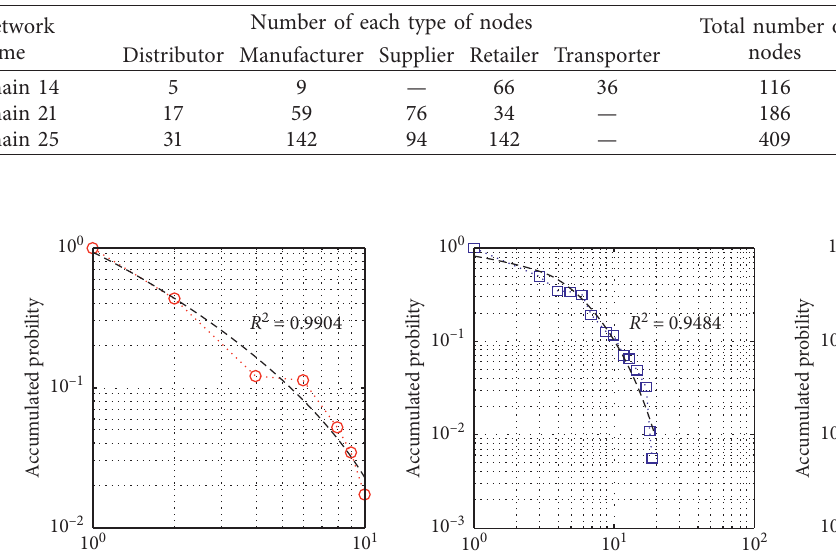
Table 1: Basic characters of the three real-life supply networks.